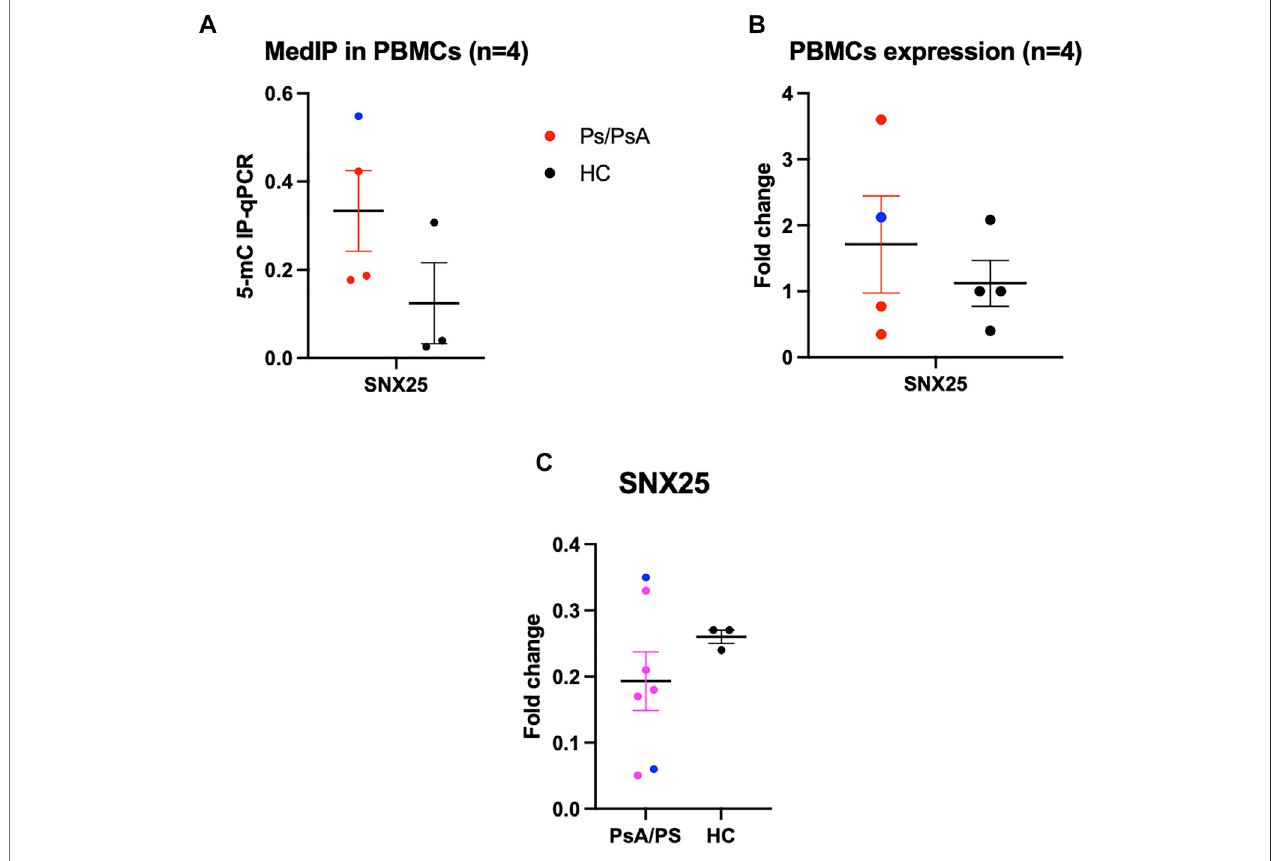
FIGURE 6 | Functional validation of SNX25 gene. (A) MeDIp of SNX25 promoter in PsA Twins. (B) mRNA expression evaluated with qPCR in PsA MZ Twins. (C) SNX25 expression evaluated in a selected cohort of Pso/PsA patients ( n (cid:2) 7) vs healthy volunteers ( n (cid:2) 3). Blue dots show PsA patients, red dots Pso patients.